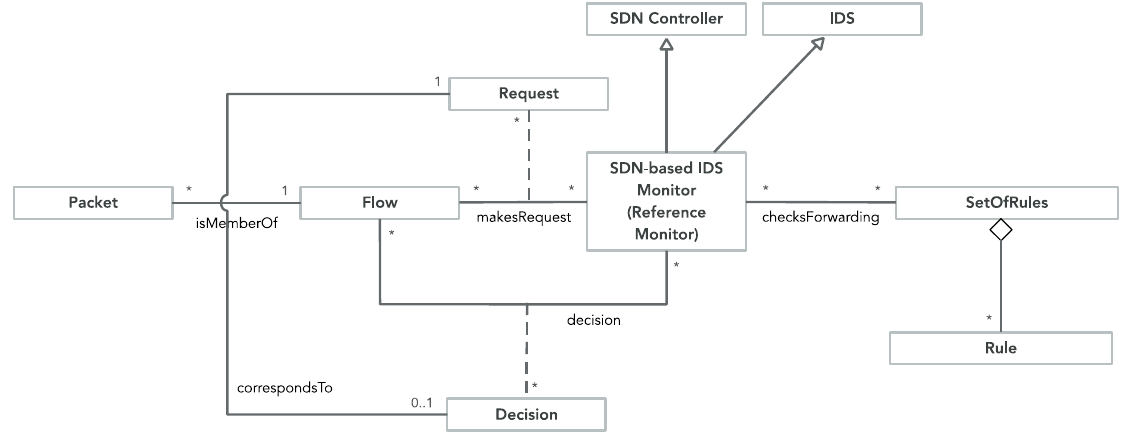
Figure 2. The System’s Conceptual Model (adapted from [24]).